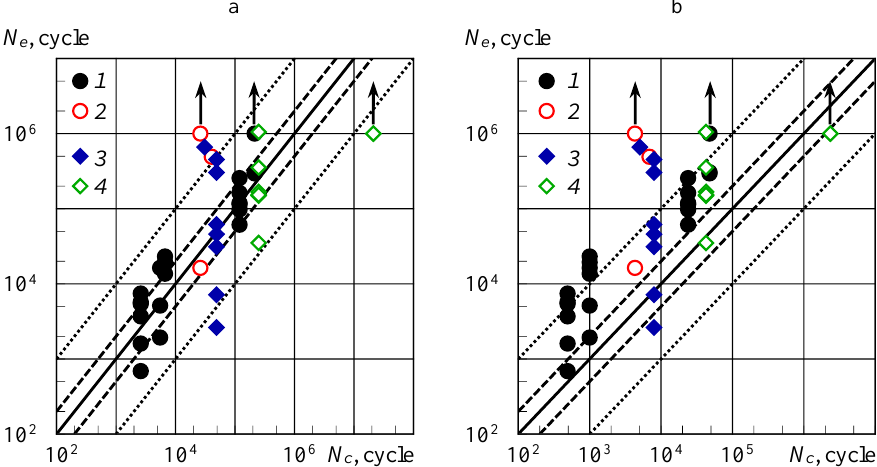
Fig. 7. Comparison of calculated N c and experimental N e endurance values of Torayca T800 carbon fiber reinforced plastic specimens for fracture probability of 0.5 (a) and 0.0228 (b);  m , MPa: 1 – 0 ( a = 0), 2 – −50 ( a = −0.177 and −0.231), 3 – −110 ( a = −0.419 and −0.493), 4 – −166.5 ( a = −1 and